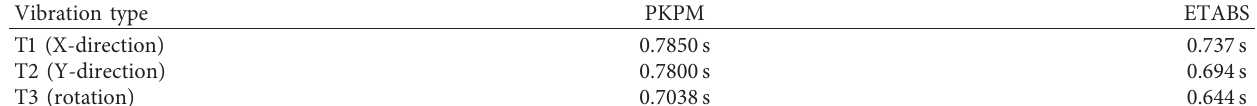
Table 6: Comparison of structural vibration mode periods calculated by PKPM and ETABS.